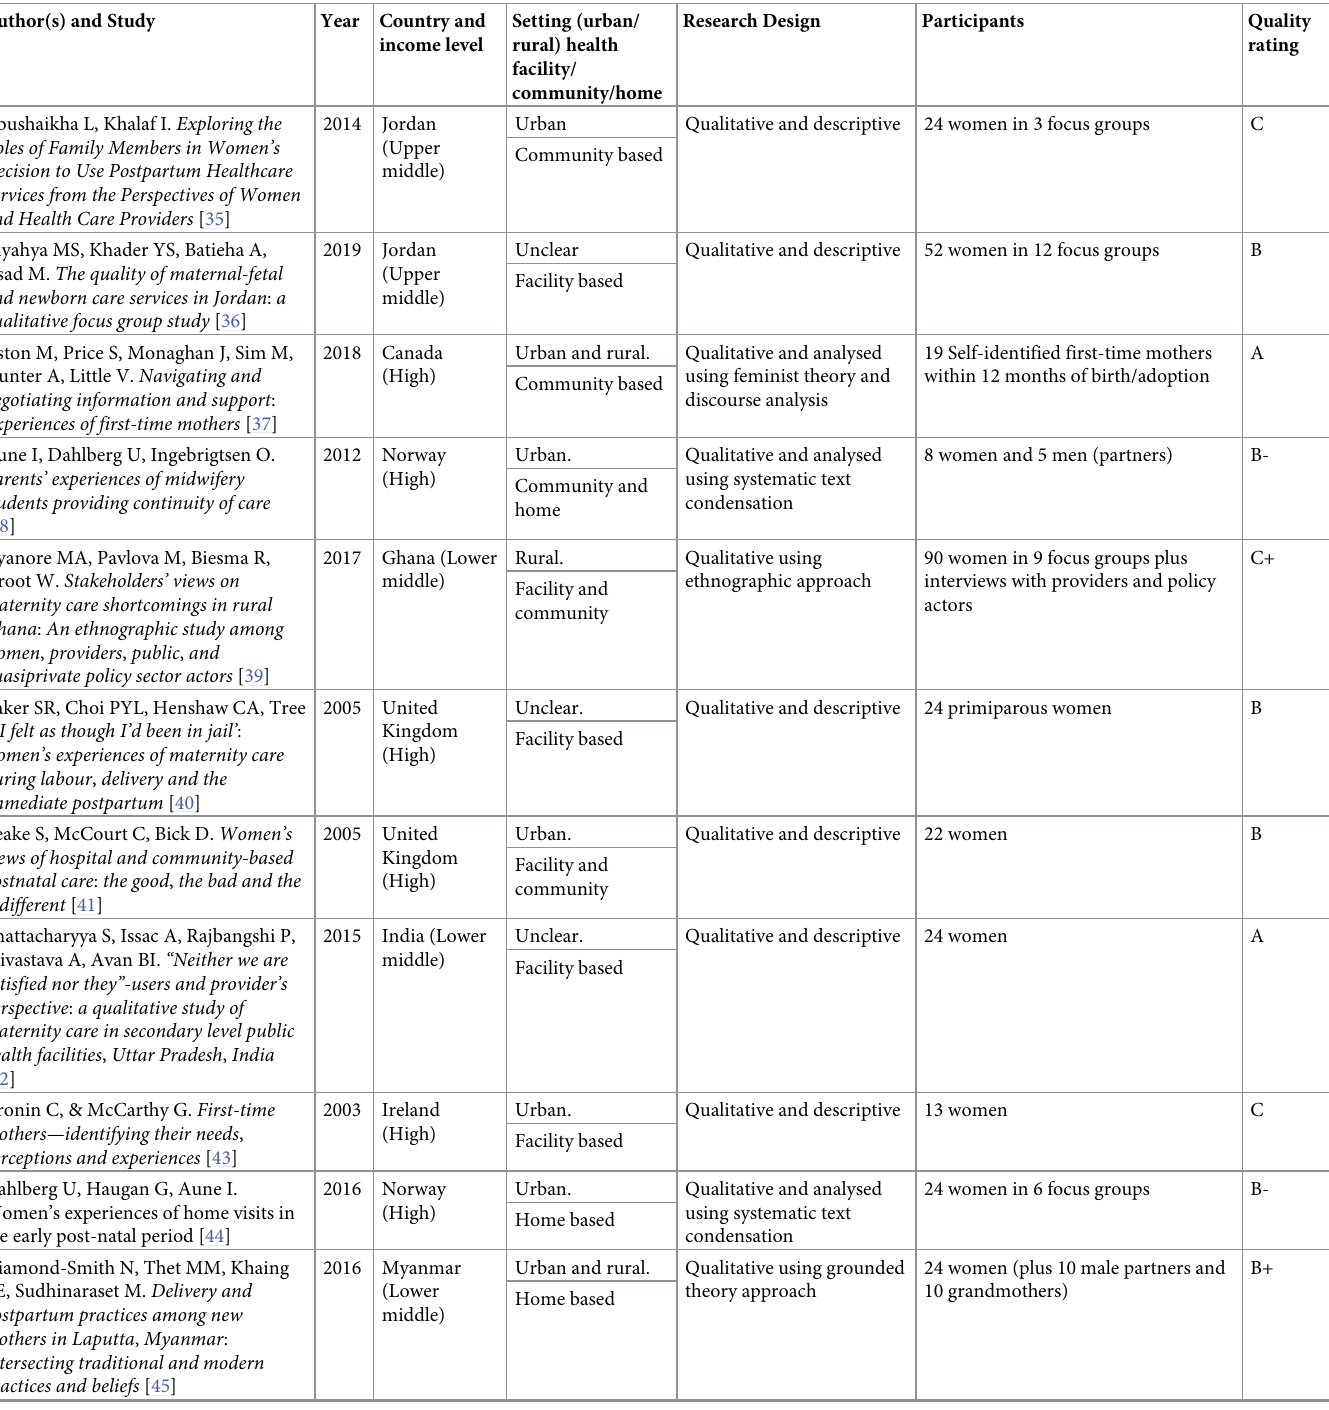
Table 3. Characteristics of included studies, alphabetical by study first